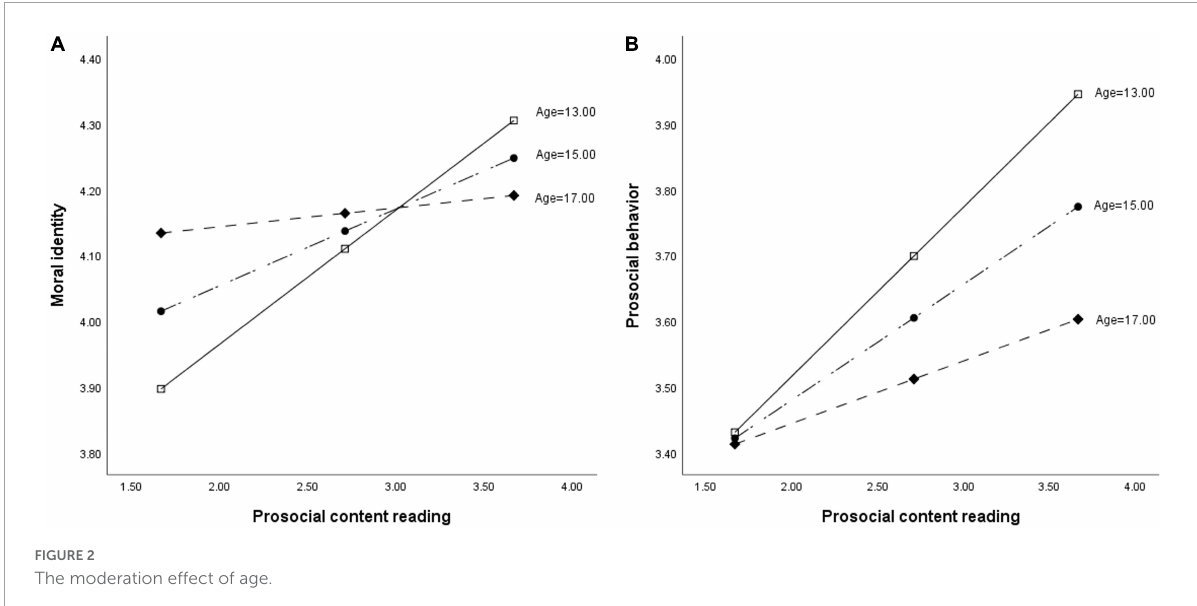
FIGURE2 The moderation effect of age.